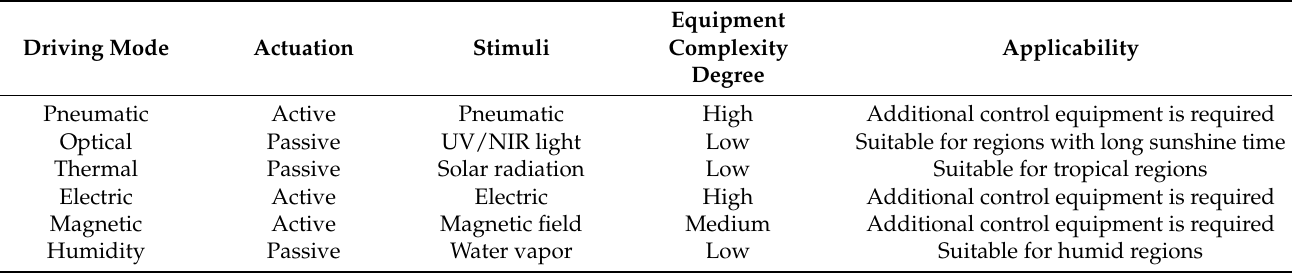
Table 1. Brief comparison of the six driving